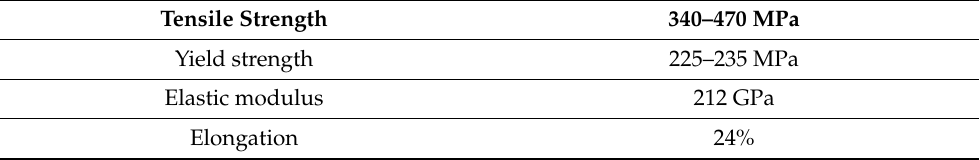
Table 1. Basic mechanical properties of the S235J0 steel at 20 °C temperature [47].